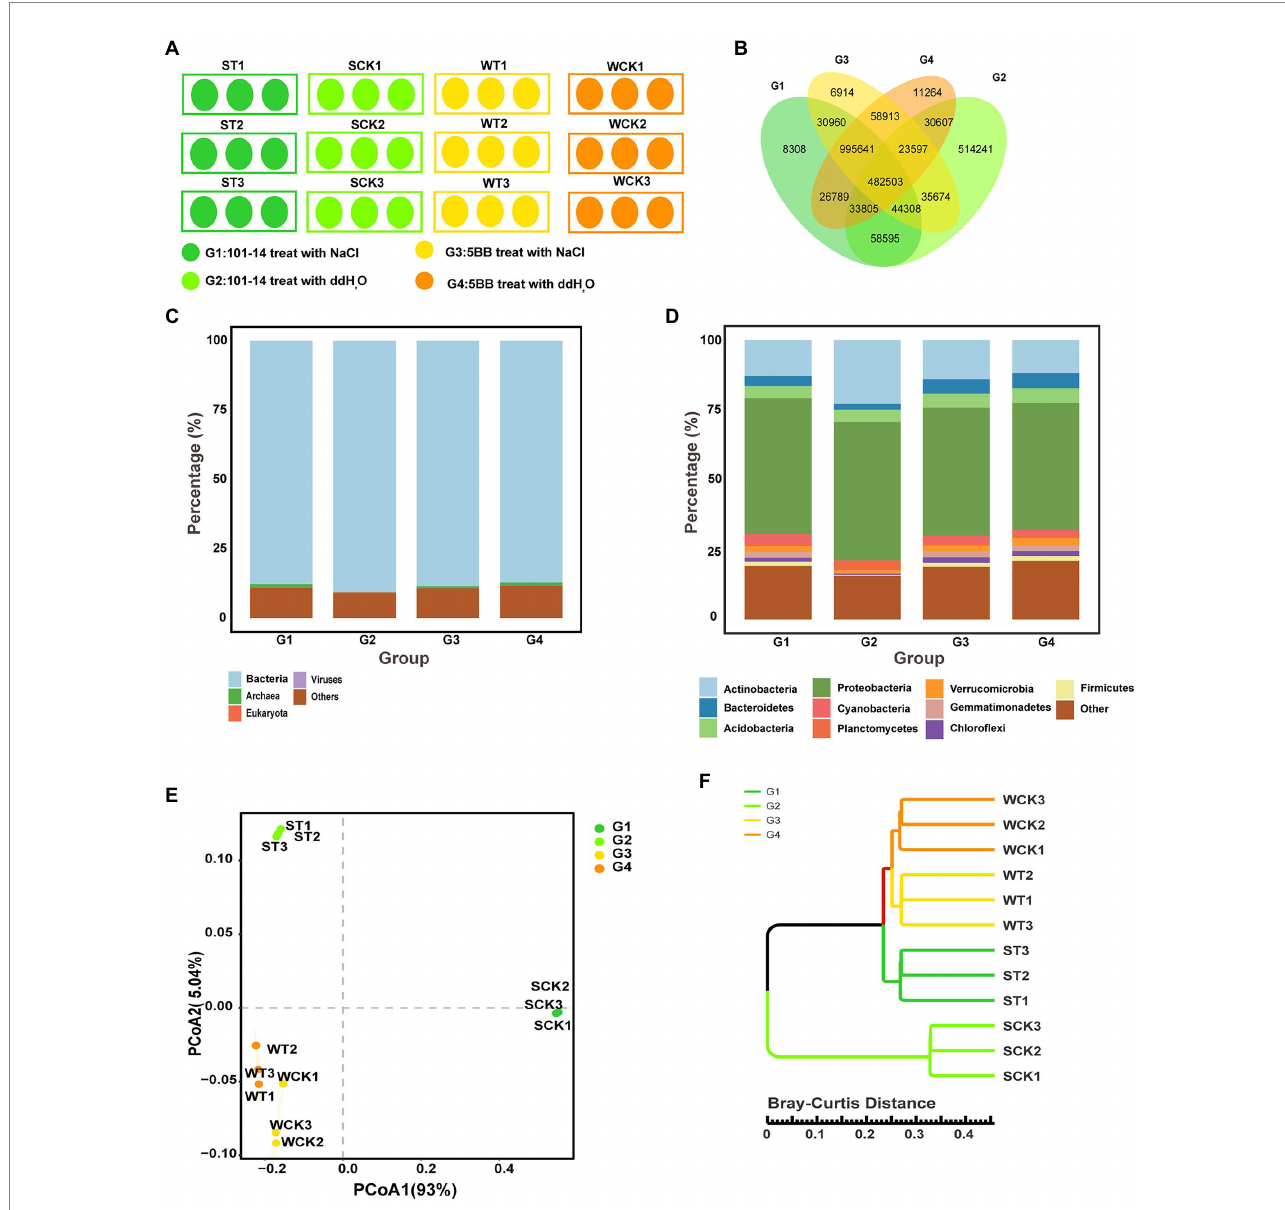
FIGURE 1 Rhizosphere soil microbiota of 101-14 and 5BB treated with NaCl and ddH 2 O. (A) Experimental design for pot cultivation study. (B) Overlapping OTUs enriched in different groups. Distribution of OTUs at the (C) kingdom and (D) phylum level in different groups. (E) Principle co-ordinates analysis based on Bray–Curtis distances of microbiota descriptions in different groups at the phylum level. (F) Cluster analysis based on Bray–Curtis distances at the genus level. G1, 101-14 treated with NaCl; G2, 101-14 treated with ddH 2 O; G3, 5BB treated with NaCl; G4, 5BB treated with ddH 2